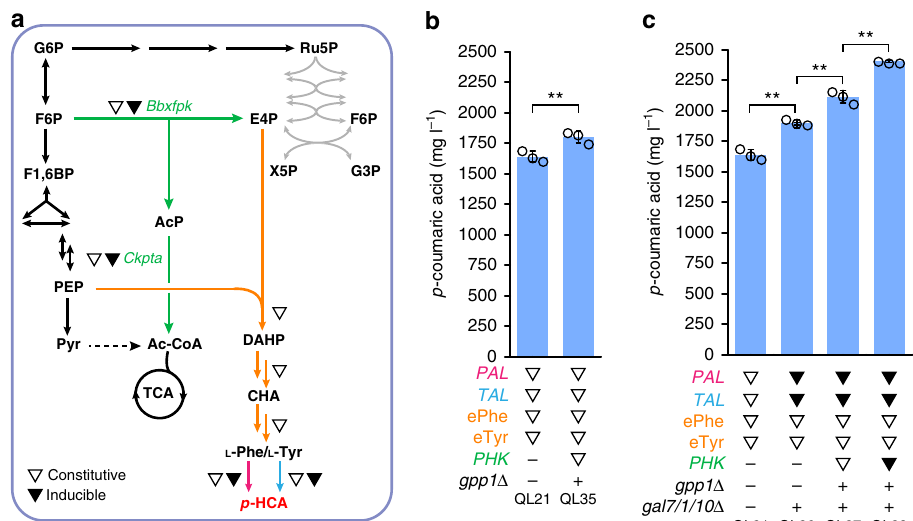
Fig. 4 Employment of a combinatorial strategy to increase the production of p -HCA. a Schematic overview of the metabolic pathway for p -HCA production with an improved supply of precursor E4P and dynamic control over the relevant biosynthetic genes, as indicated by triangle symbols: open triangles indicate the use of constitutive strong promoters to control gene expression, while fi lled triangles indicate the use of galactose-inducible promoters. See Fig. 1 legend regarding abbreviations of metabolites and Fig. 3 legend for gene details. b Integration of the PHK pathway with combined ePhe- PAL and eTyr- TAL branches leads to increased p -HCA production. eTyr refers to enhanced tyrosine biosynthesis mediated through the bene fi cial effect of MtPDH1 . c Dynamic control of biosynthetic genes via use of the GALp -controlled expression system signi fi cantly increases p -HCA production. Cells were grown in de fi ned minimal medium with six tablets of FeedBeads as the sole carbon source and 1% galactose as the inducer when required. Cultures were sampled after 96 h of growth for p -HCA detection. Statistical analysis was performed by using Student ’ s t test (one-tailed; two-sample unequal variance; * p < 0.05, ** p < 0.01, *** p < 0.001). All data represent the mean of n = 3 biologically independent samples and error bars show standard deviation. The source data of fi gures b and c are provided in a Source Data fi